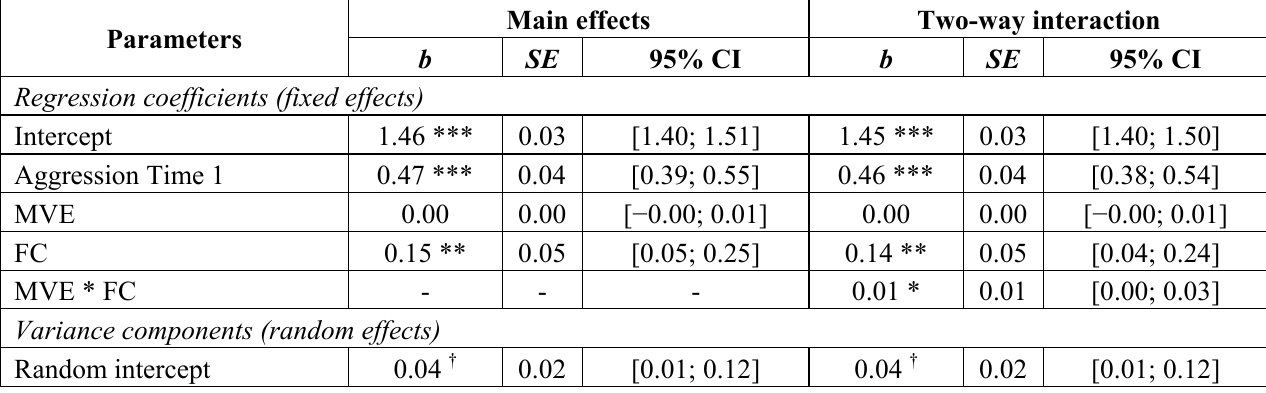
Table 2. Unstandardized regression coefficients, standard errors, and 95% confidence intervals (CI) predicting Time 2 aggressive